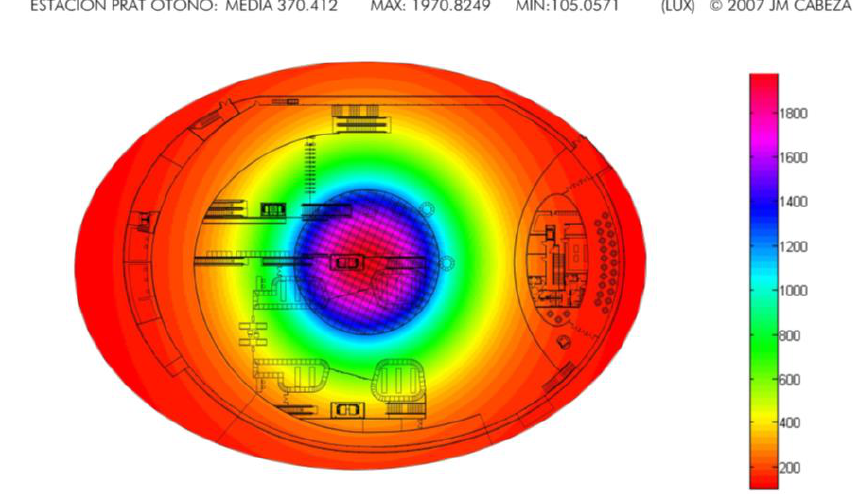
Figure 23. Distribution of radiation in autumn in plan. Values in Lux.